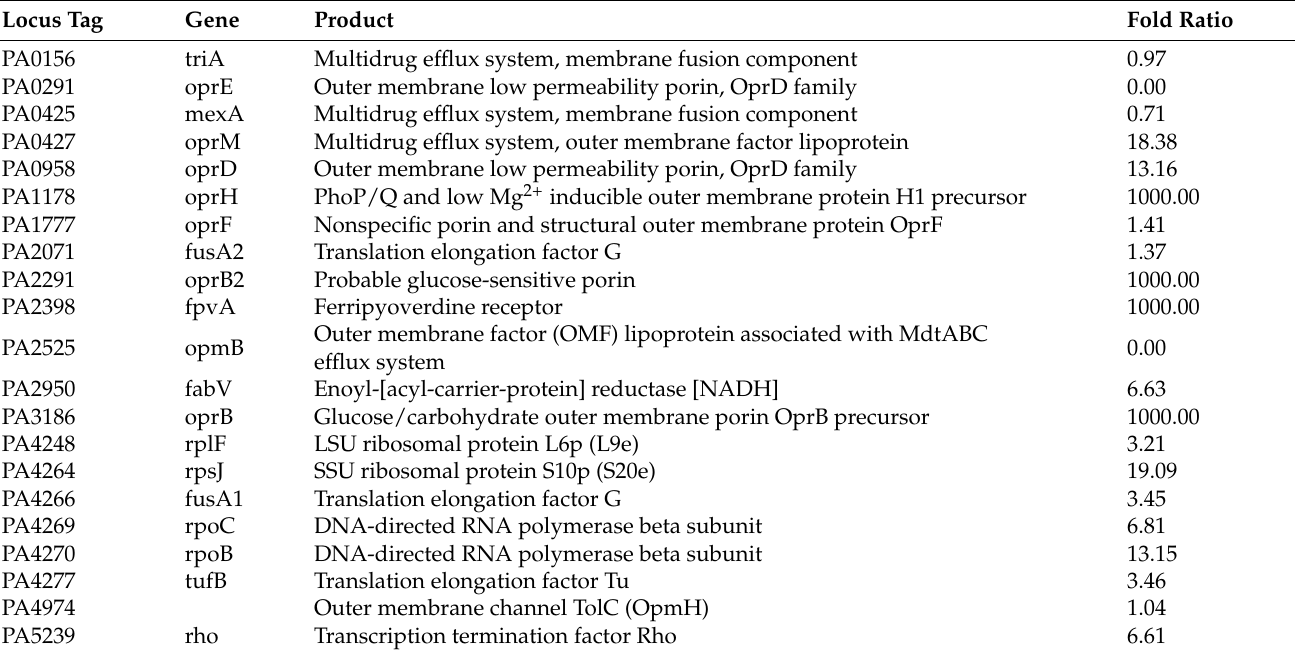
Table 1. Identified proteins associated with antibiotic resistance of planktonic cells grown with control and antibiotic- impregnated